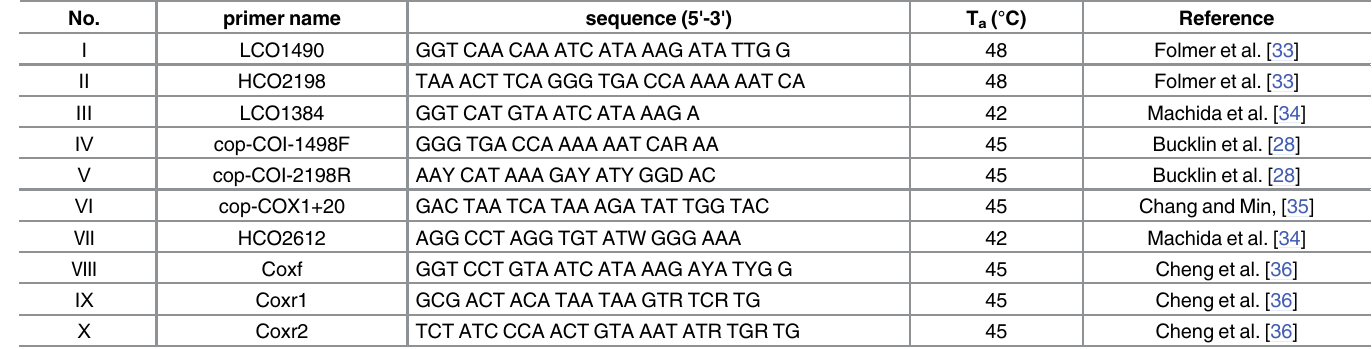
Table 2. Ten primers used for PCR amplification of partial COI from 133 individuals of 94 copepod species in this study. Primer sequences are given in 5 0 to 3 0 direction. Amplification difficulty caused by sequence variation of primer binding sites was resolved with mixed bases; R is a mixture of A and G, Y is a mixture of C and T, W is a mixture of A and T, D is a mixture of G, T and C. References are given for each primer.